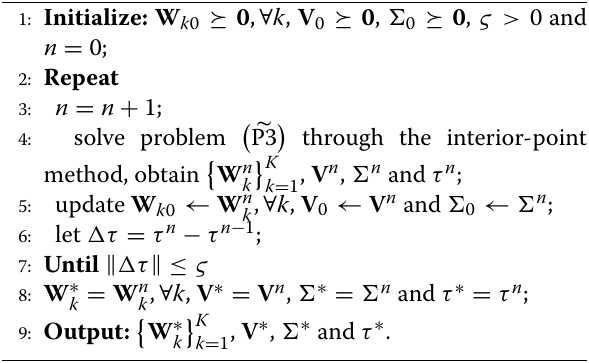
Algorithm 1 An iterative algorithm for solving